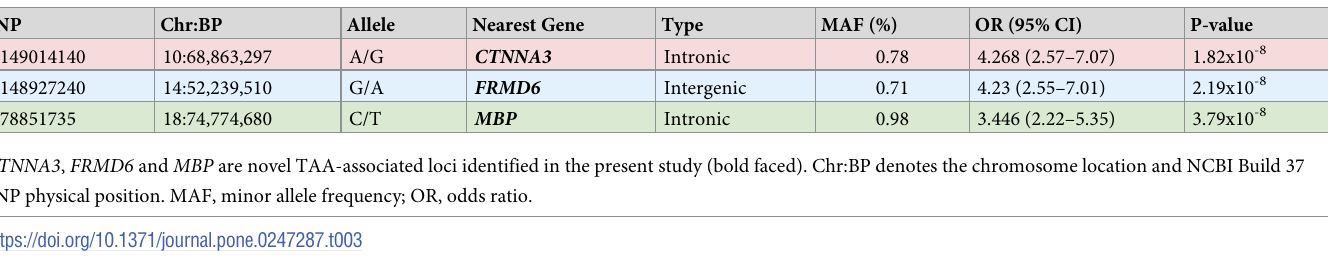
Table 3. SNPs in 3 novel loci associated with thoracic aortic aneurysm.